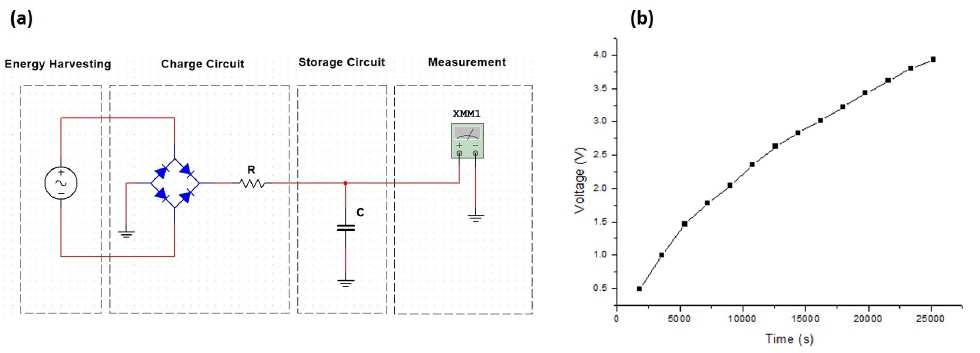
Figure 10. ( a ) Circuit for testing charging of a 1 µF capacitor; ( b ) voltage obtained as a function of charging